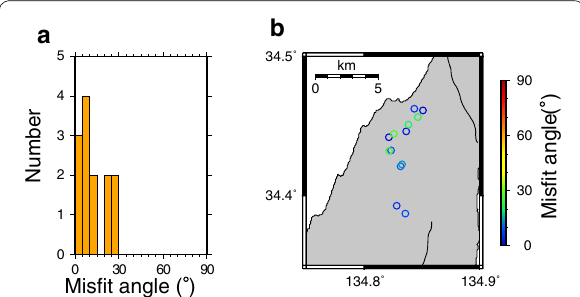
Fig. 10 Misfit angles of Pre-shock2 with respect to the optimal stress tensor derived from aftershocks (i.e., a driving stress of Awaji Island earthquake). a Frequency. b Spatial